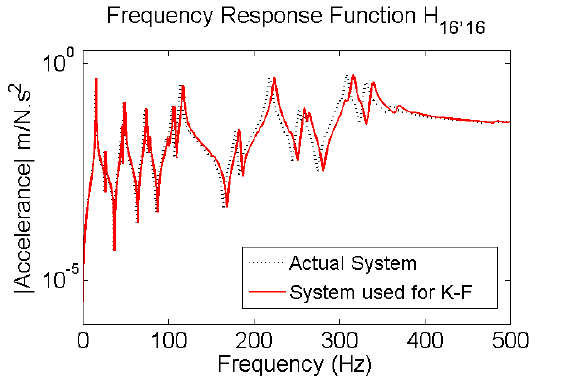
Figure 6. Dotted black: FRF of the system that is used for simulation of response; Solid red line: FRF of the perturbed system, to represent modeling error (5%) used for input estimation.